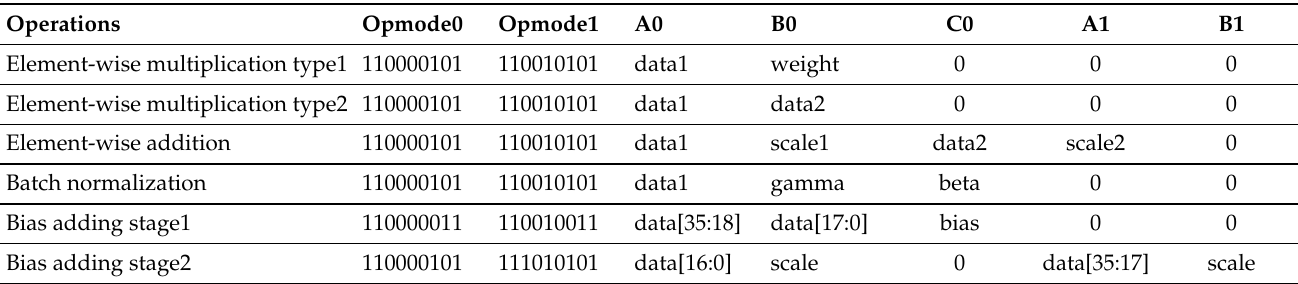
Table 1. Configuration modes and opcodes of the